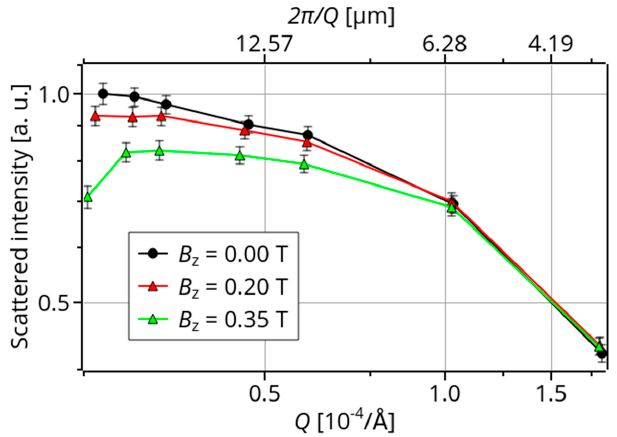
Figure 2. USANS curves of the MAE samples with 10 mass% of Fe for three different values of the magnetic flux density B z .